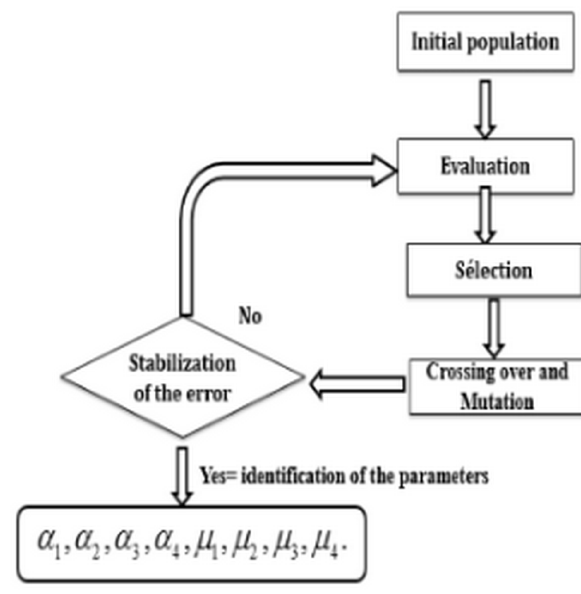
is founded on enumerative method which is the binary searching method. The second part uses the simplicity of genetic algorithms subjecting the population of possible results to process of replication, crossing-over and muta- tion